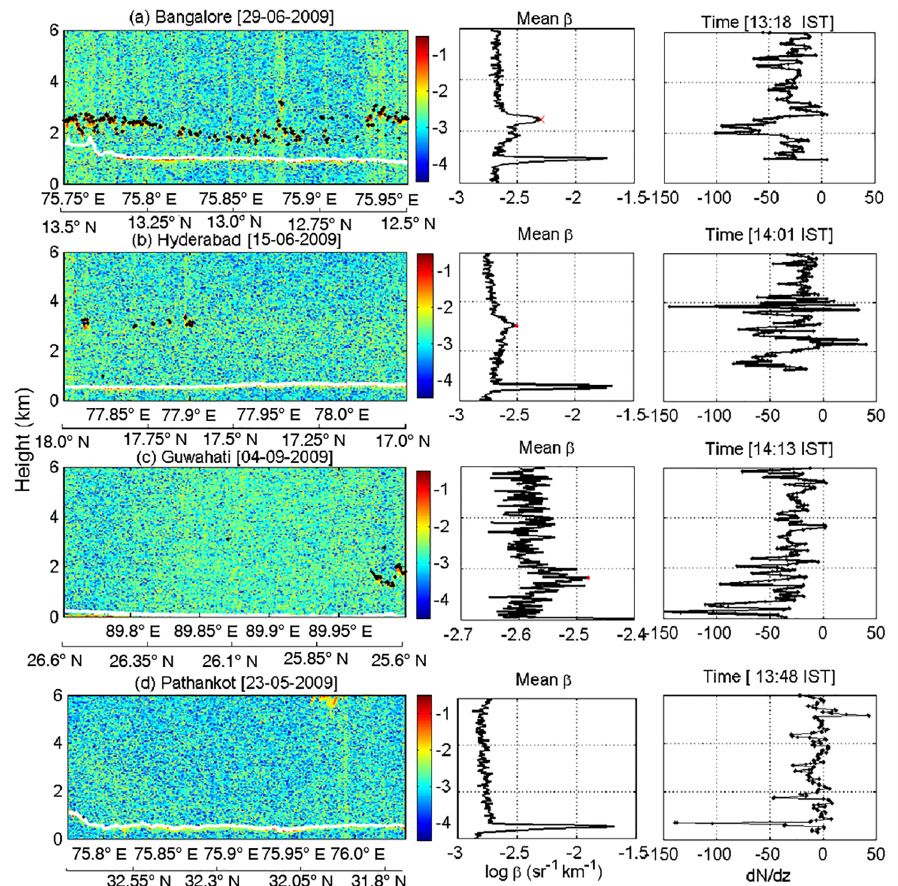
Figure 10. Typical comparison of the CBL obtained using the CALIPSO backscattering coefficients collected within ± 0.5 ◦ latitude centred at each radiosonde site (first column panels). Mean backscattering coefficients over the entire 1 ◦ latitude track (second column panels) and radiosonde refractivity profiles (third column panels) observed over (a) Bangalore on 29 June 2009, (b) Hyderabad on 15 June 2009, (c) Guwahati on 4 September 2009, and (d) Pathankot on 23 May